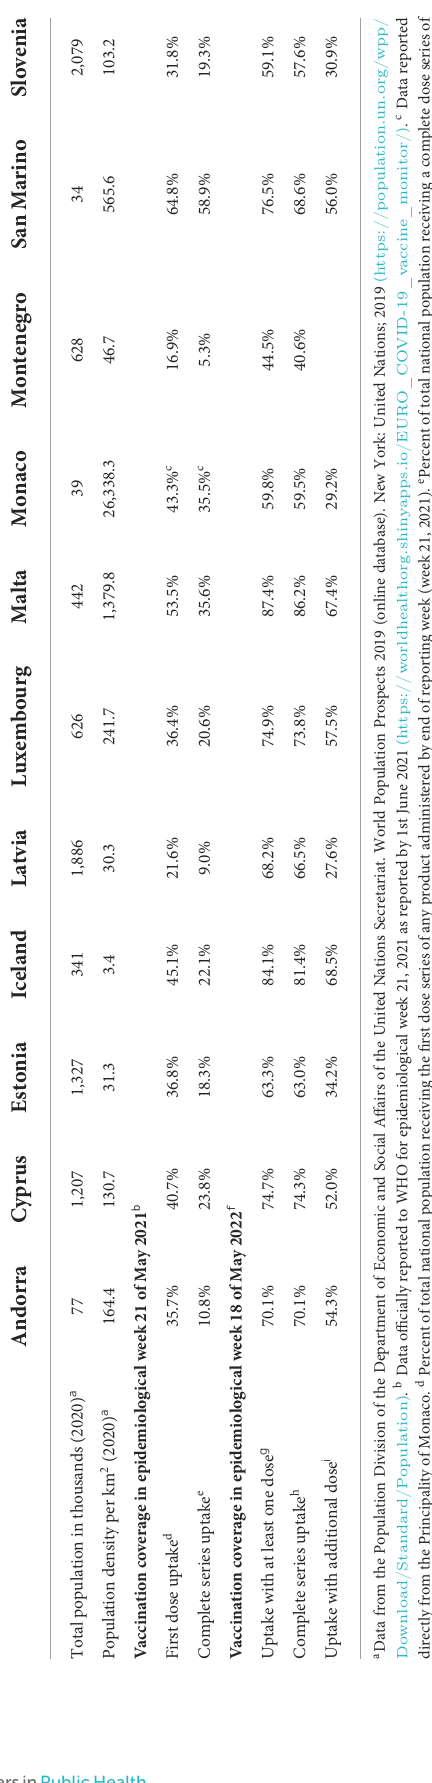
TABLE 2 Questions used as a base for email and video-call interviews with country focal points in the Small Countries